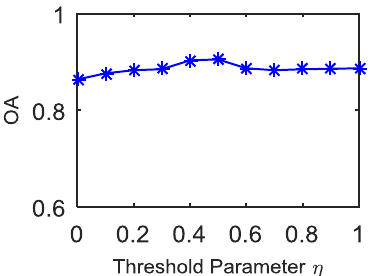
Figure 22. SVM classification accuracies of Indian Pines data (104–108, 150–163, 220 removed).